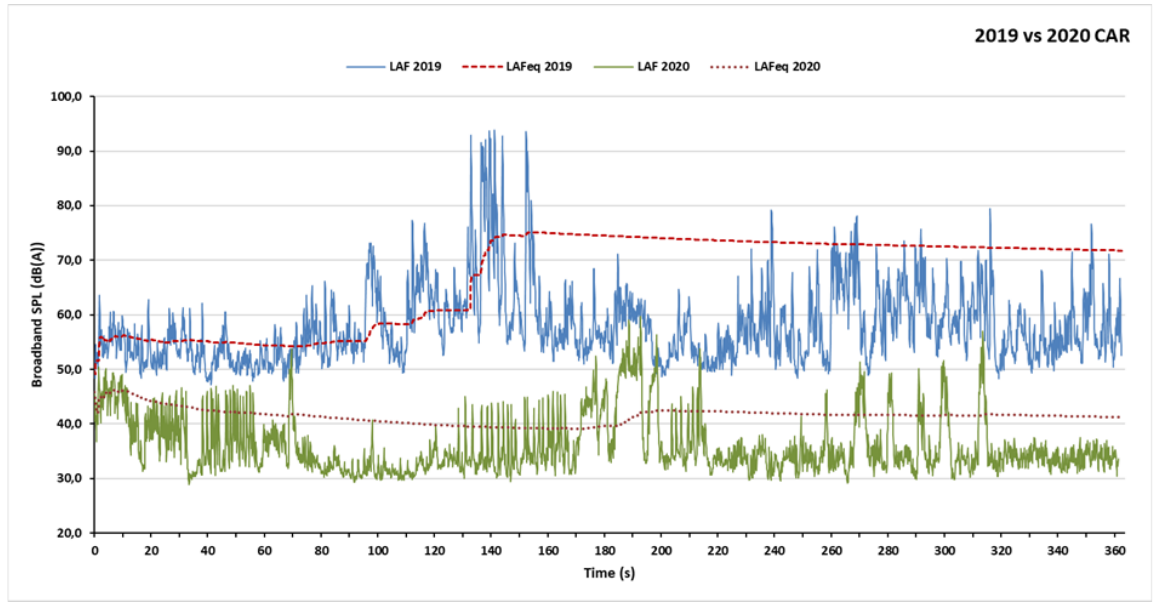
Figure 10: Broadband sound pressure levels in 2019 and during the lockdown in 2020 for the six minutes period recording together with the equivalent noise level at site no. 1